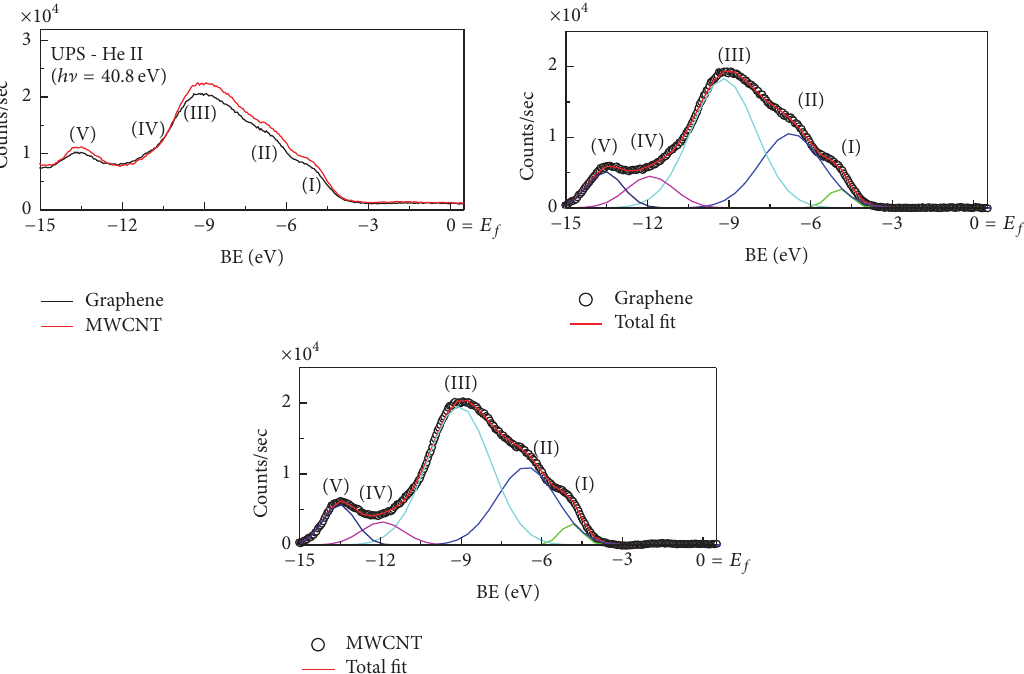
Figure 5: UPS spectra (He-II = 40.8 eV) of graphene and MWCNTs. Deconvolution into five Gaussian components for each FLG and